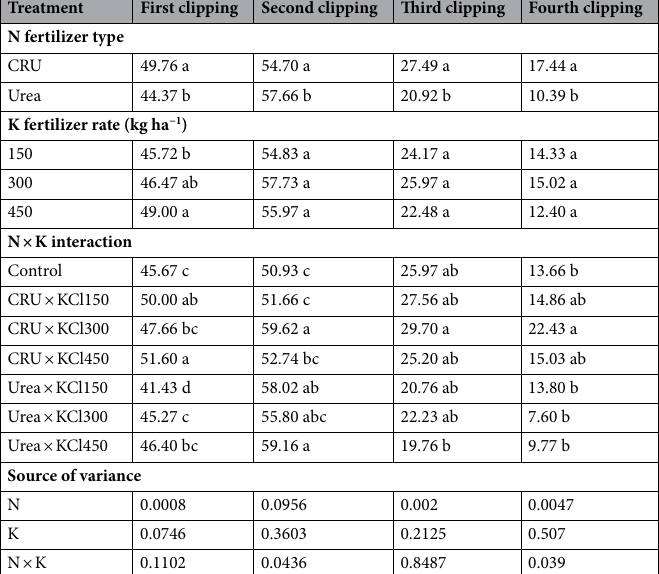
Table 3. The leaf SPAD value of Italian ryegrass. Means followed by different lowercase letters in the same column were significantly different based on analyses with ANOVAs followed by Duncan tests ( P < 0.05). Control no N and K fertilizer, CRU controlled-release urea, KCl potassium